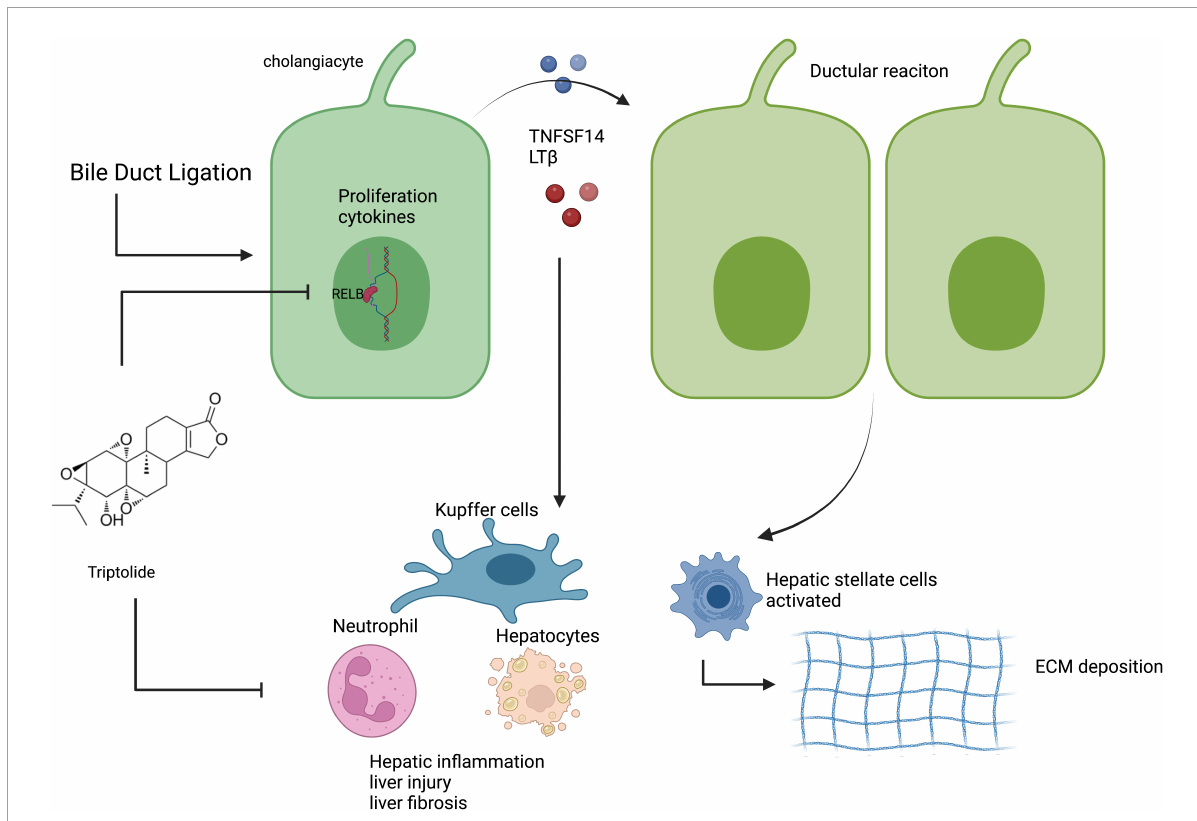
FIGURE7 TP inhibited the BDL-induced ductular reaction by reducing the expression of RelB in cholangiocytes, thereby alleviating liver injury, fibrosis, and inflammation. Created with BioRender.com.